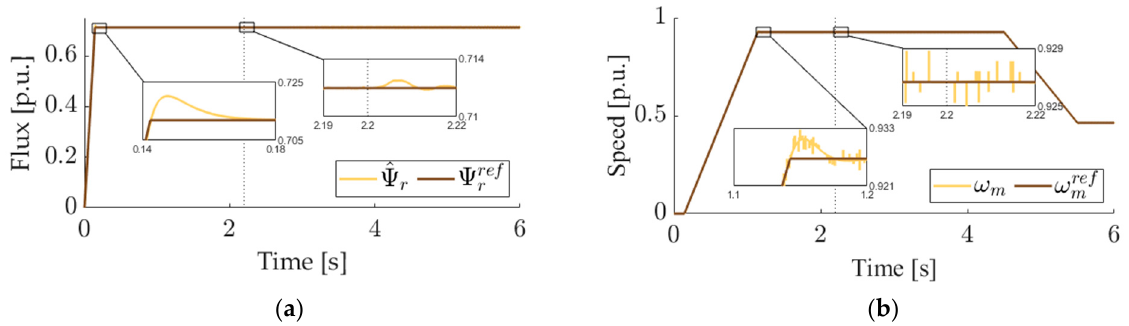
Figure 14. Waveforms of the rotor flux amplitude ( a ) and angular speed ( b ).